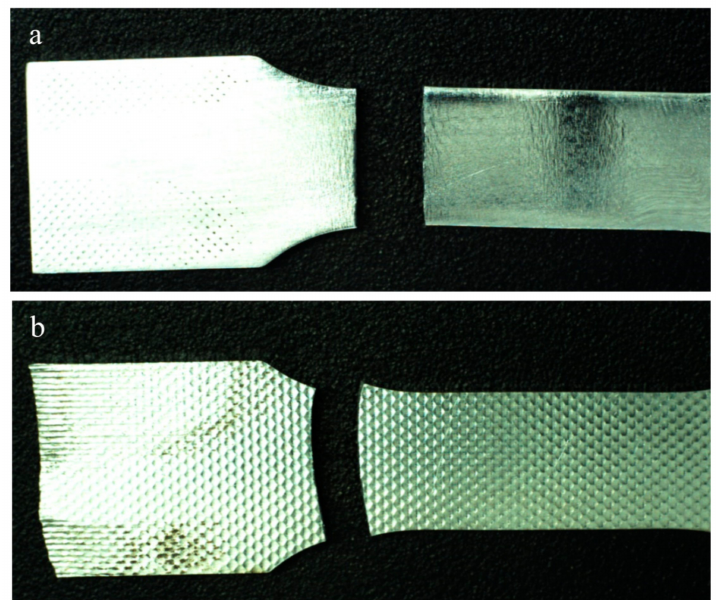
Figure 8. Comparison of fatigue tensile fracture of polished surface and surface morphology of quadrilateral bionic pit: ( a ) fatigue fracture of polished surface; ( b ) fatigue fracture of quadrilateral bionic pit